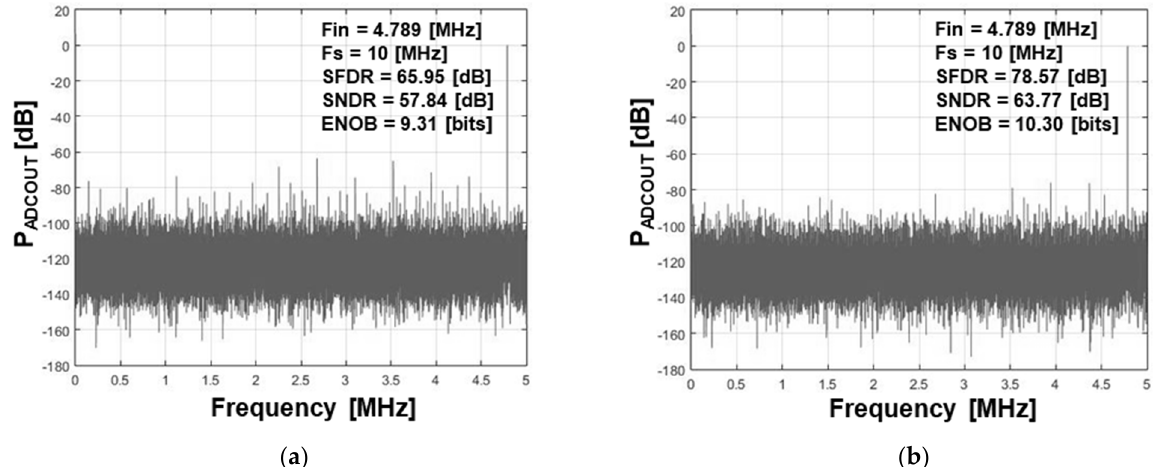
Figure 11. Measured dynamic performances of 11-bit SAR ADC at a differential analog input signal with Nyquist frequency of 4.78 MHz: ( a ) before C–R DAC calibration; ( b ) after C–R DAC calibration.